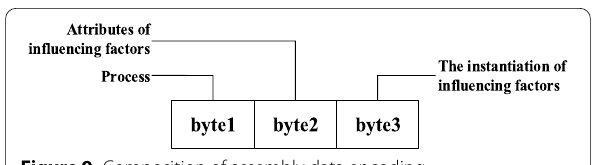
Figure 9 Composition of assembly data